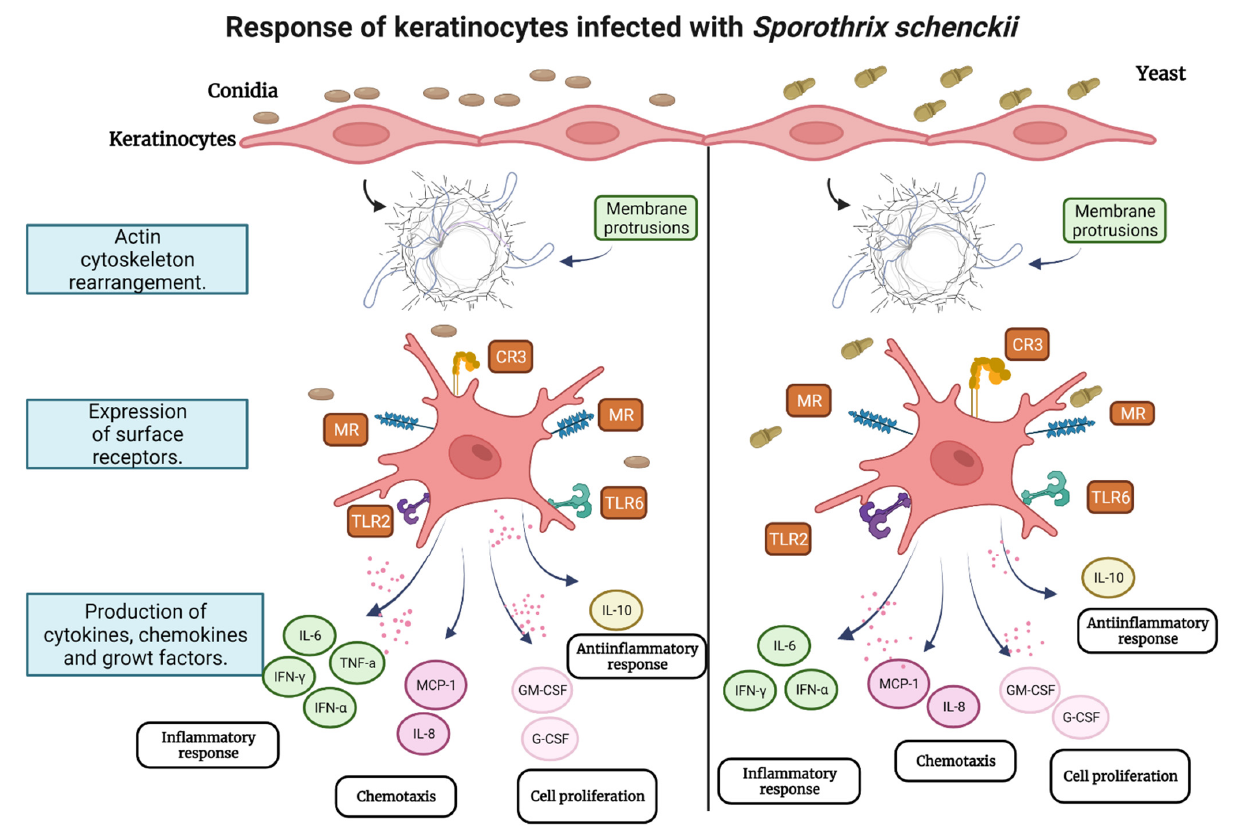
Figure 9. Hypothetical model of keratinocyte response during infection with conidia and yeast cells of S.